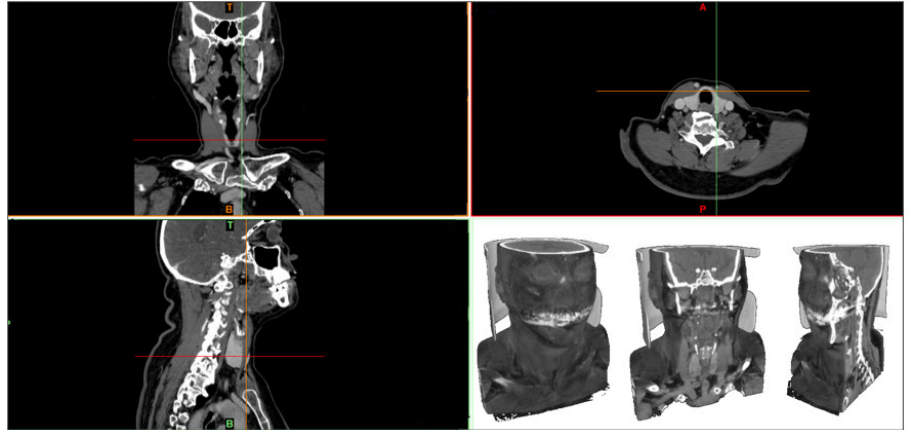
Figure 4. MIMICS software interface, where it is possible to observe the anatomical planes (sagittal, coronal, and axial).